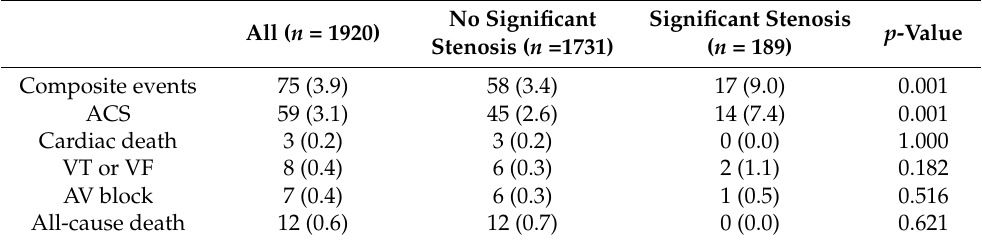
Table 3. Clinical event rate of patients with VA according to significant stenosis of coronary artery.